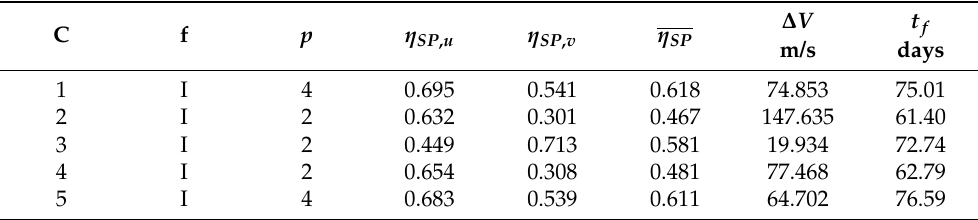
Table 6. EML2 escapes performance—fixed C 3 = 0.5 ( km/s ) 2 , free t f